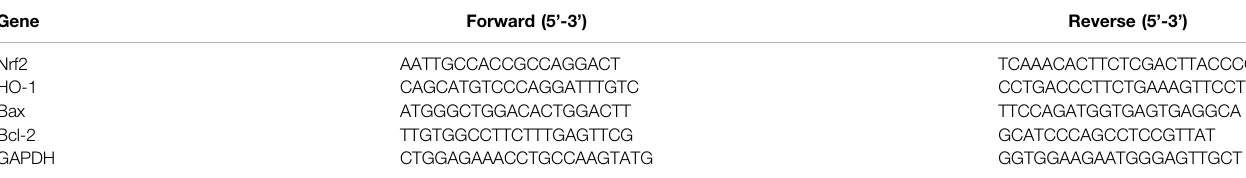
TABLE 1 | Primers used for quantitative real-time PCR.